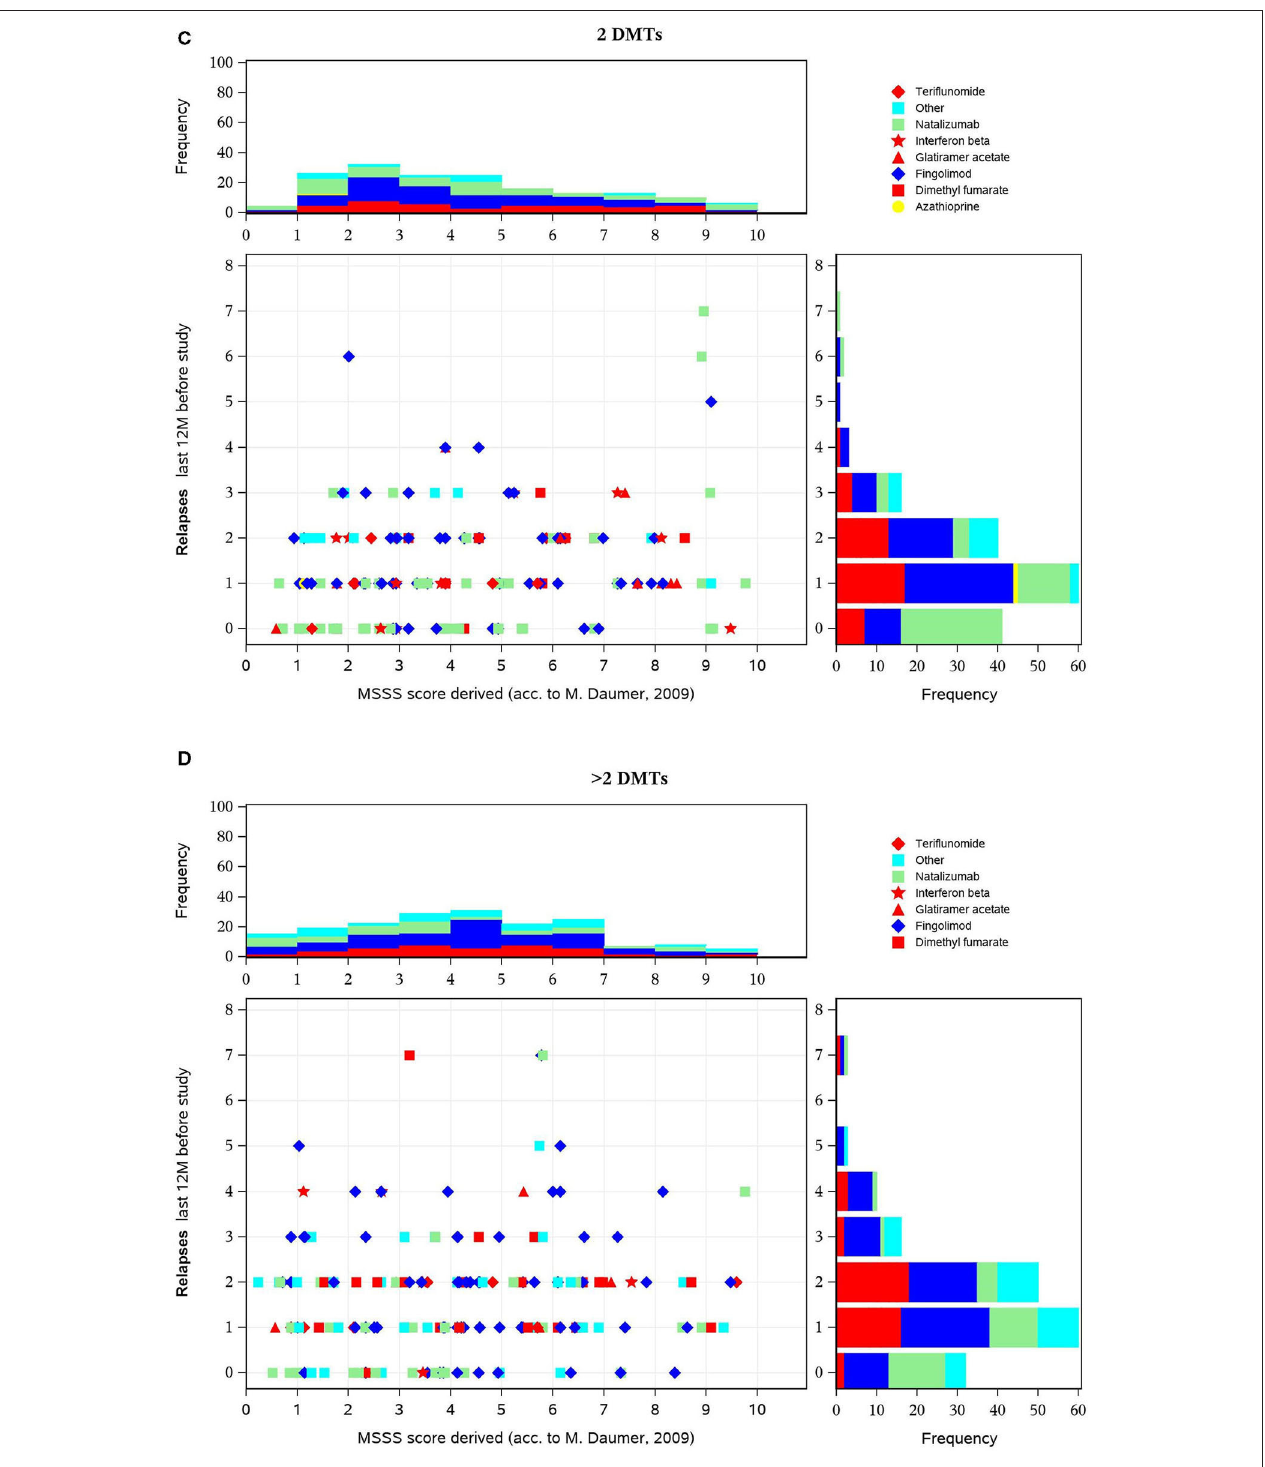
FIGURE 3 | (A–D) Multiple Sclerosis Severity Score (MSSS) (y-axis) vs. number of exacerbations (x-axis) in the 12 months before inclusion, by disease-modifying treatment (DMT) pretreatment. These figures display scatterplots of MSSS (x-axis) vs. number of relapses (y axis) in the 12 months before inclusion, in patients with no, one, two, or more DMT at baseline. In all subgroups, there was a peak of one or two relapses and a similar distribution with a predominance of lower MSSS values. There is no distinct pattern of medication use in the various groups. However, escalation therapy is more often used in patients with a higher number of disease-modifying treatments